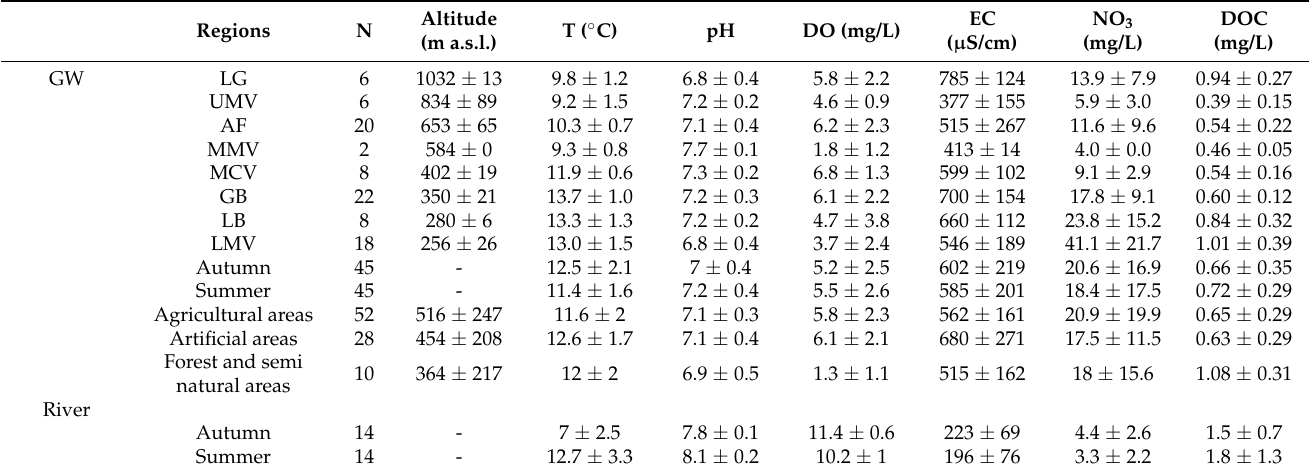
Table 1. Key physicochemical features of groundwater (GW) and river water samples collected in the River Mur Valley in summer and autumn 2020. Data are means ±